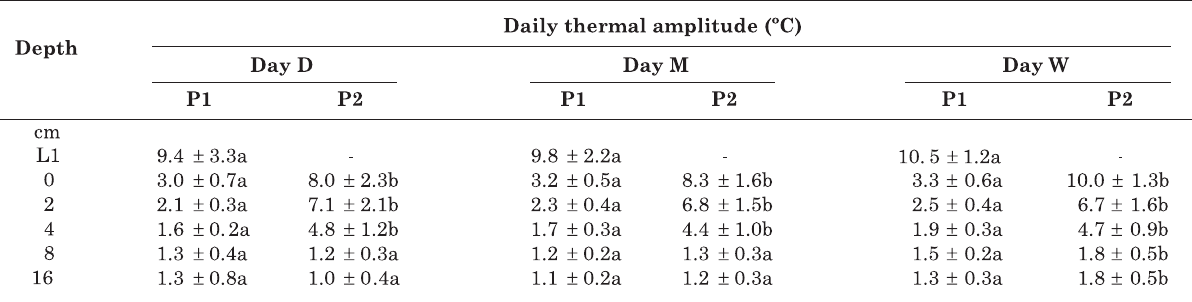
At each depth, values followed by different letters are significantly different (*p < 0.05).